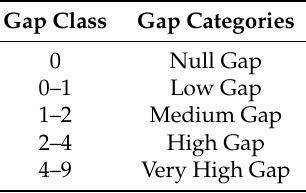
Table 3. Gap categories and classes for behaviors